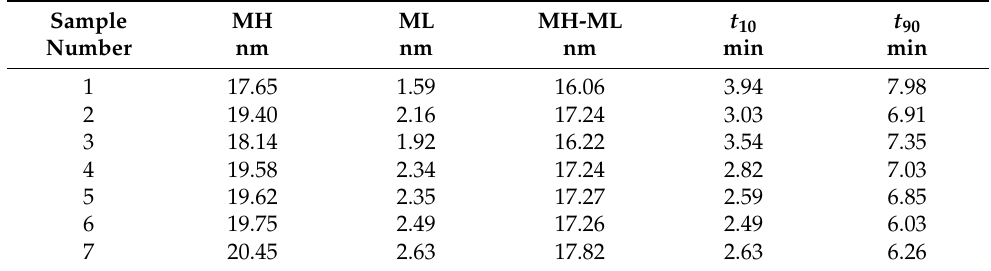
Table 2. Vulcanization characteristics of the CNT/WPRP/NR